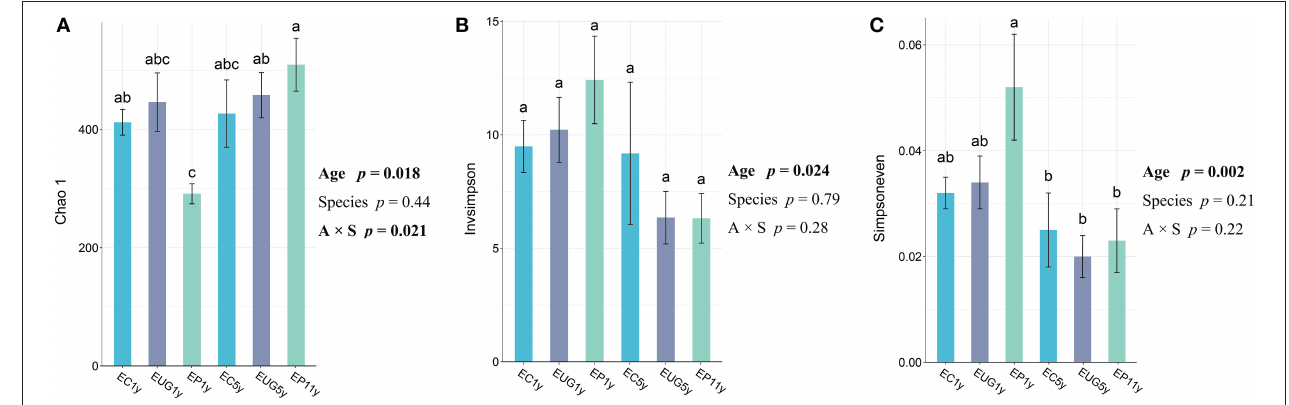
FIGURE 1 | Fungal alpha diversity indexes of (A) richness, (B) diversity, and (C) evenness in Eucalyptus plantations with different ages and species. Two-way ANOVA model summary for responses of alpha diversity indexes and explanatory variables of Eucalyptus plantation age, species, and their interaction. Explanatory variables deemed statistically significant are bolded. One-way ANOVA and Tukey [honestly significant difference (HSD) post-hoc pairwise comparison tests ( p < 0.05) were performed after checking for assumptions of normality and homoscedasticity. Accessions with the same letter were not significantly different. EC, Eucalyptus